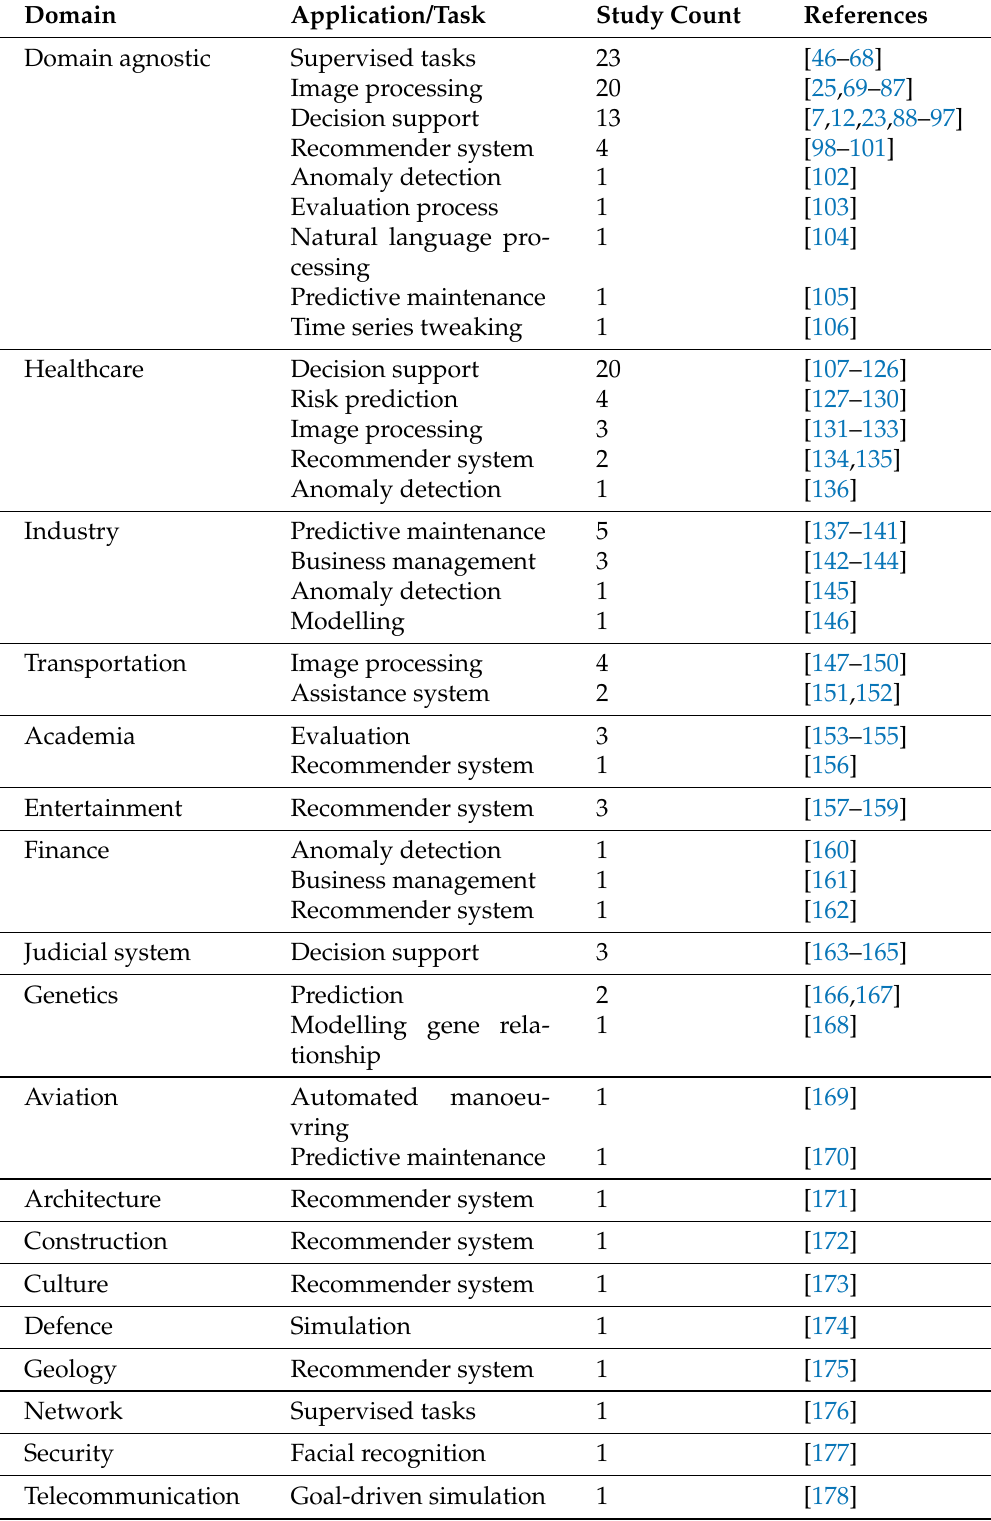
Table 4. List of references to selected articles published on the methods of XAI from different application domains for the corresponding